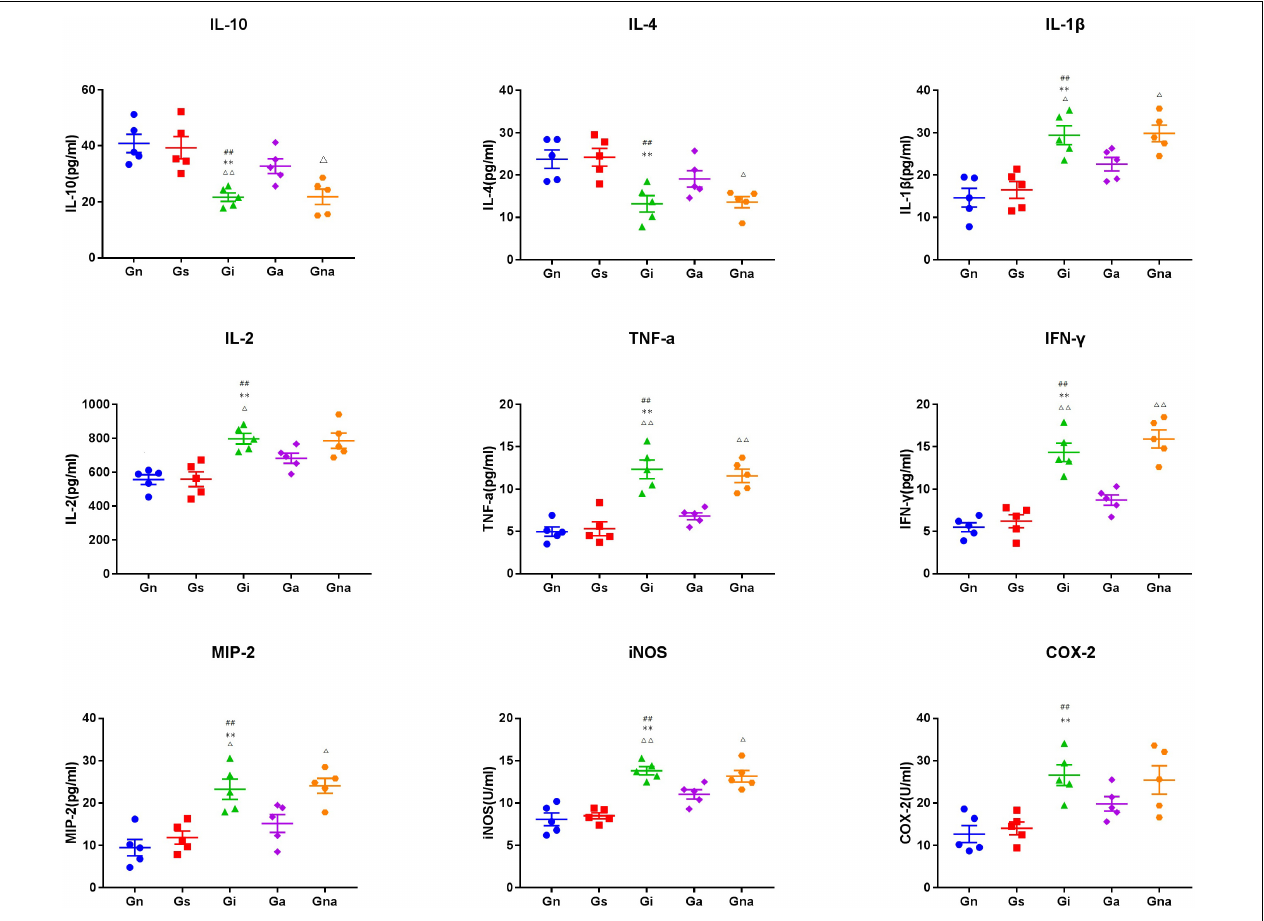
FIGURE 6 | Effect of acupuncture on the levels of related inflammatory mediators in serum. The data are expressed as the mean ± SEM ( n = 5). ** P < 0.01, vs. Gn group; # P < 0.05, ## P < 0.01, vs. Gs group; (cid:77) P < 0.05, (cid:77)(cid:77) P < 0.01, vs. Ga group. Gn, normal group; Gs, sham-operated group; Gi, impaired group; Ga, acupoint group; Gna, non-acupoint